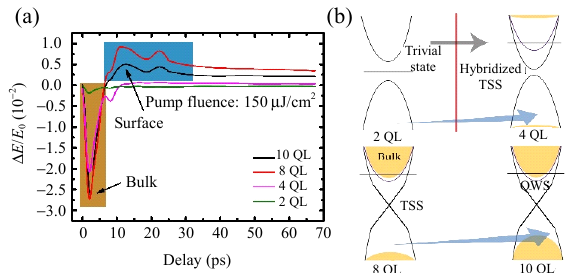
Fig. 2 Thickness-dependent topological phase transition: (a) measured transient THz transmission spectra for the Bi 2 Se 3 samples with different layers (i.e., 2 QL, 4 QL, 8 QL, and 10 QL) showing a double phases recombination process for various time delays and (b) evolution of the band structure of the Bi 2 Se 3 films with an increase in the layer number from 2 QL to 10